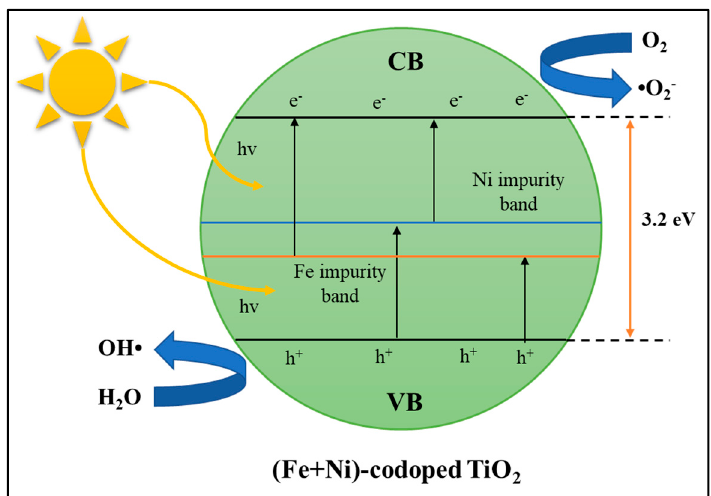
Figure 19. Schematic illustration of energy band level in (Fe + Ni)-codoped TiO 2 system. Cation–Anion